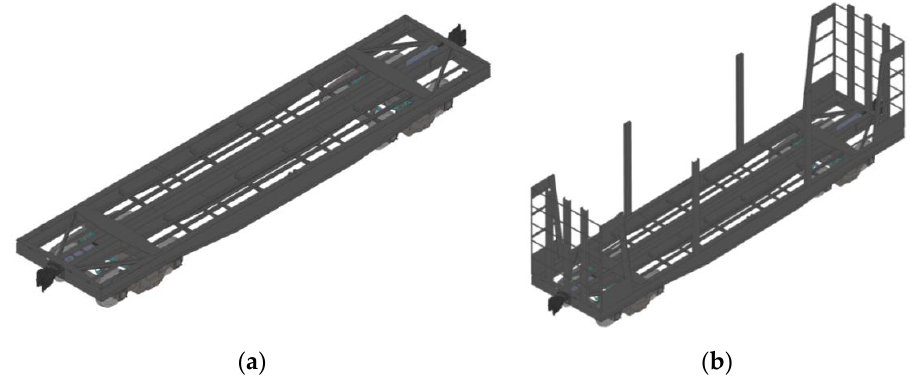
Figure 2. Flat wagon of model 13-401: ( a ) typical design of a flat wagon; ( b ) improved flat wagon design.